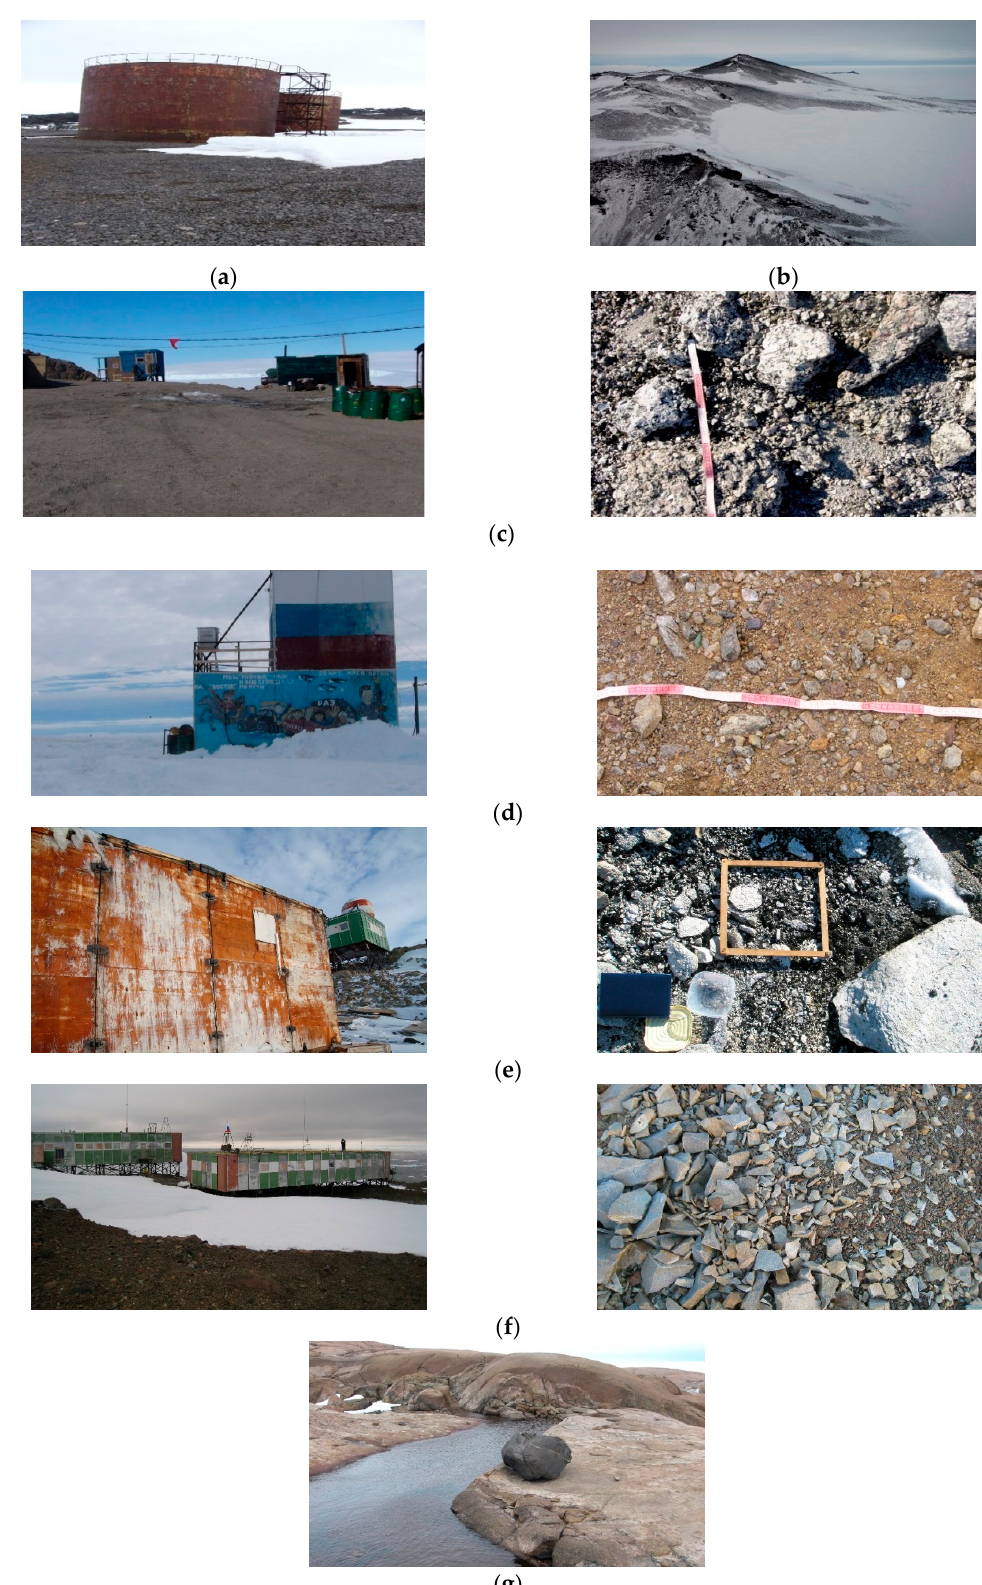
Figure 2. Anthropogenic and natural landscapes of the studied Antarctic stations and their vicinity: ( a ) Bellingshausen Station; ( b ) the Hudson Mountains; ( c ) Druzhnaya 4 Station; ( d ) Mirniy Station; ( e ) Leningradskaya Station; ( f ) Russkaya Station; ( g ) the Haswell Archipelago.